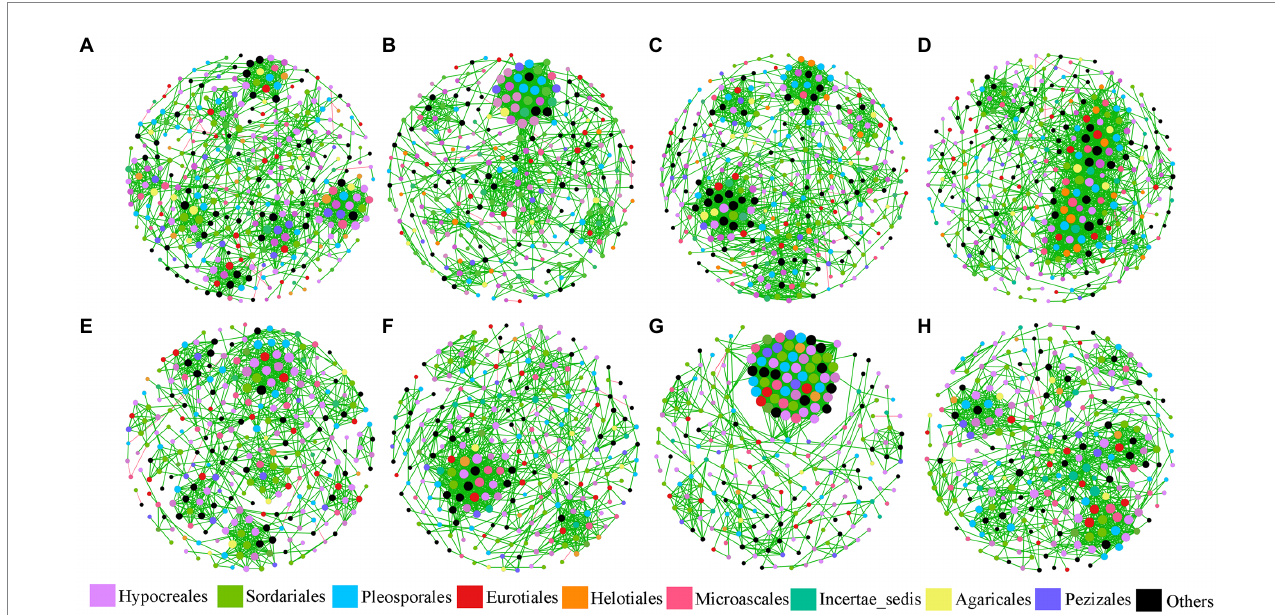
FIGURE 1 Visualization of fungal networks for each treatment in two soils. (A–D) are control, L, M, and H treatments in JSJ soil, respectively; and (E–H) are control, L, M, and H treatments in LF soil, respectively.